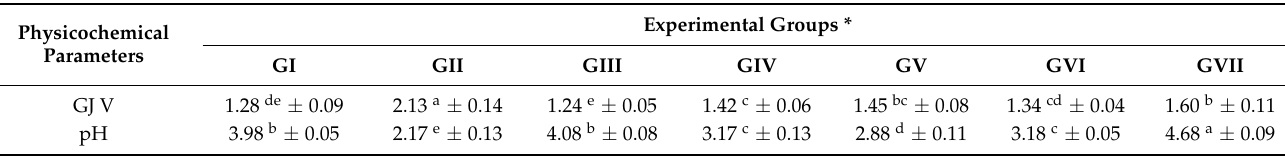
GJV: gastric juice volume (mL), * GI: negative control, GII: positive ulcer control; GIII: ulcer + SP; GIV: Ulcer + KF; GV: ulcer + KP; GVI: ulcer + SFP; GVII: ulcer + Lansoprazole (reference group), a–e values with the same superscript letter in the same raw are not significantly different at p ≤ 0.05. Table 2. Effect of SP, KF, KP, and SFP on ulcer and protection indexes of indomethacin-induced gastric ulcer in rats (mean ± SE), n = 6.